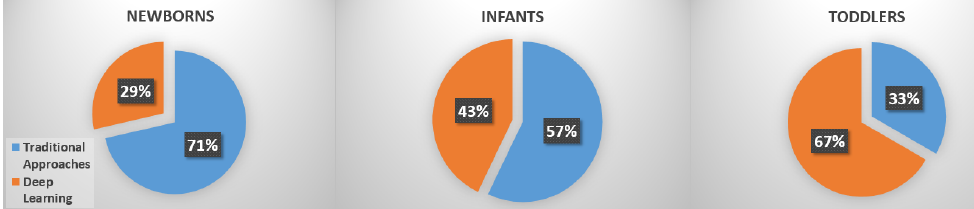
Figure 2. Percentages of published papers with respect to Age Range taxonomy.